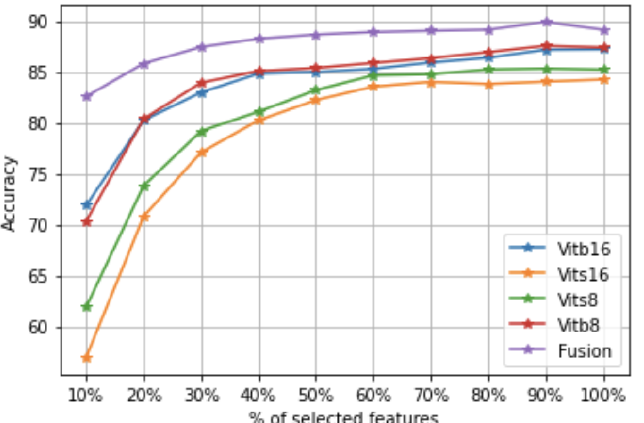
Figure 13. Rate of important feature effects on the classification accuracy of the NWPU-RESISC45 data set with 10% randomly selected images per